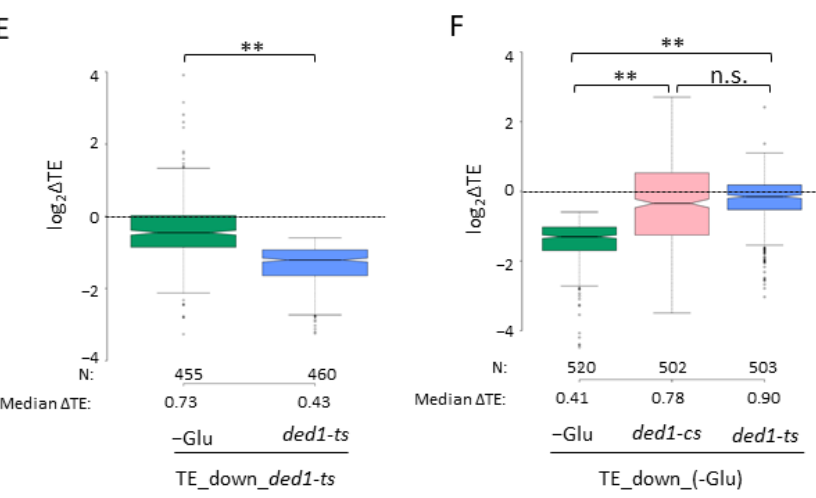
Figure 1. A significant fraction of Ded1-hyperdependent mRNAs in glucose-replete conditions is translationally down-regulated by glucose starvation. ( A ) Venn diagram of overlap between 520 mRNAs exhibiting ≥ 1.5-fold decrease in TE at FDR < 0.05 in WT cells under − Glu versus +Glu conditions (TE_down_( − Glu) group) and 1505 mRNAs showing a comparable decrease in TE in ded1-cs versus WT cells shifted to low temperature in a glucose-replete medium (TE_down_ ded1-cs group) out of a total of 5474 mRNAs for which ribosome-profiling data were obtained in the ded1-cs experiment. TE change values were calculated from published ribosome-profiling data deposited on GEO: − Glu/+Glu, GSE51532; ded1-cs /WT, GSE 111255. For this and all Venn diagrams below, the fold-enrichment and p value for the overlap was assigned using a hypergeometric distribution. ( B ) Notched box plot analysis of the log2 fold-changes in TE (log2 ∆ TE) observed in response to glu- cose starvation ( − Glu), the ded1-cs mutation for the 1505 TE_down_ ded1-cs mRNAs (col. 1–2), or the 208 mRNAs in the overlap between the TE_down_( − Glu) and TE_down_ ded1-cs mRNAs in panel A (cols. 3–4). In this and all box plots below, each box depicts the interquartile range containing 50% of the data, intersected by the median; the notch indicates a 95% confidence interval (CI) around the me- dian. Thus, if the notches in two boxes do not overlap, their medians differ with 95% confidence. If the notches of a box overlap zero on the y -axis, then the median log2FC for that group does not differ sig- nificantly from the median log2FC for all mRNAs, which equals zero due to normalization. p values from a Mann–Whitney U-test reporting the statistical significance of the difference in medians be- tween the distributions in boxplots are indicated. Unlogged median TE change values are indicated below the x -axis. ( C ) Overlap between the mRNAs in the TE_down_ ded1-cs group from ( A ) and the 460 mRNAs exhibiting a ≥ 1.5-fold decrease in TE at FDR < 0.05 in ded1-ts versus WT cells shifted to high temperature in a glucose-replete medium (TE_down_ ded1-ts group) out of a total of 5494 mRNAs for which ribosome-profiling data were obtained in the ded1-ts experiment. ( D ) Analysis as in ( A ) but for the TE_down_( − Glu) and TE_down_ ded1-ts groups of mRNAs from ( A – C ). ( E ) Notched box plots showing log2 fold-changes in TE in response to ( − Glu) or ded1-ts for the 460 TE_down_ ded1- ts mRNAs. ( F ) Notched box plots showing log2 fold-changes in TE in response to ( − Glu), ded1-cs , or ded1-ts for the 520 TE_down_( − Glu) mRNAs. p -values computed from Mann–Whitney U-test are given (* p < 10 − 3 ; ** p < 10 − 15 ; n.s., not